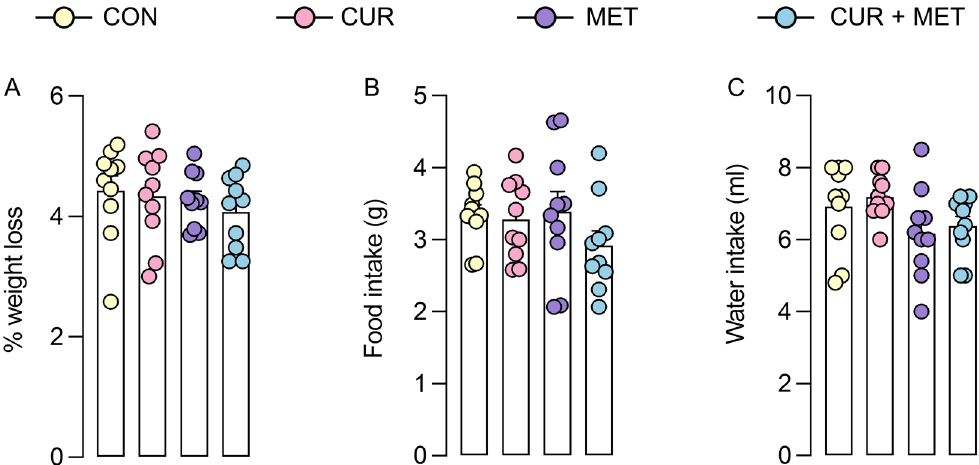
Figure 10. Percentage weight loss, food intake, and water intake of mice after 24 h treatment with curcumin and metformin alone or in combination. The weight of the mice and food and water volume supplied to each cage were measured pre-, and post-test (24 h). The percentage weight loss ( A ) and food intake ( B ), and water intake ( C ) were calculated and presented as mean ± S.E.M (n = 10